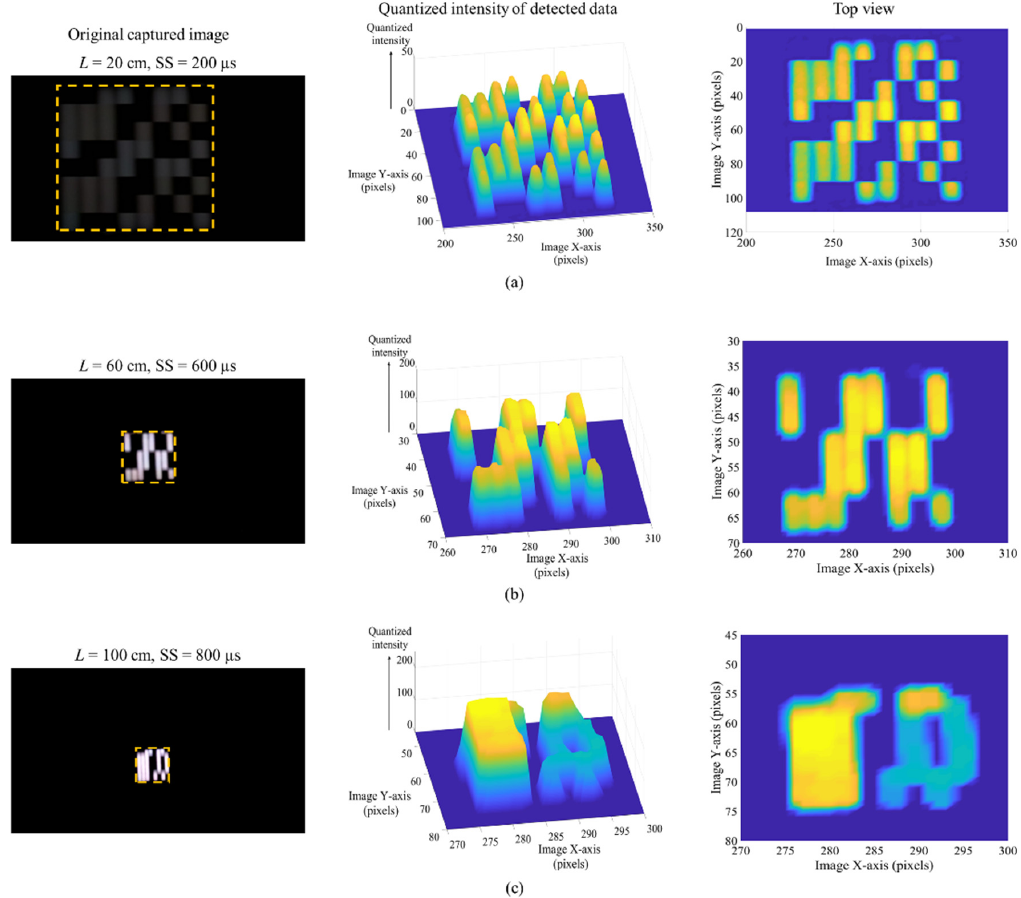
Figure 9. MIMO ‐ OCC performance analysis with grouping grid and diffuser: the quantized intensity profiles of originally captured images for data detection at: ( a ) L = 20 cm and SS = 200 μ s; ( b ) L = 60 cm and SS = 600 µ s; and ( c ) L = 100 cm and SS = 800 µ s.